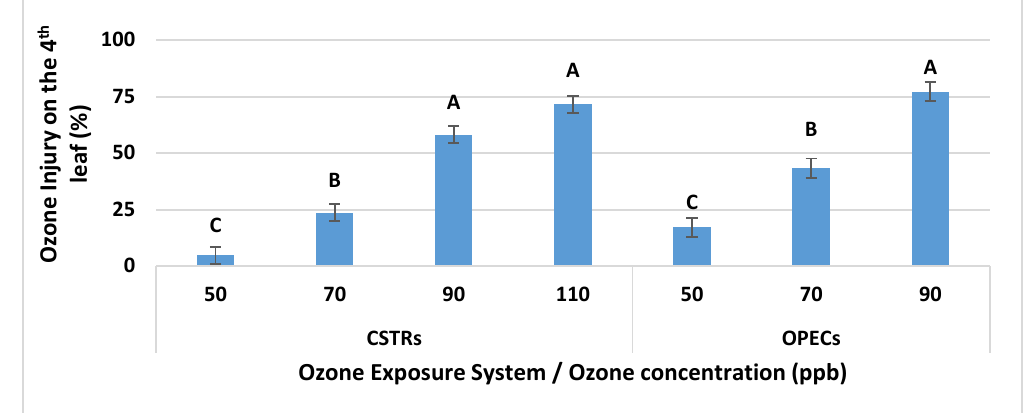
Figure 3. The overall average (±SE) of ozone injury of eight rust near-universal susceptible (RnUS) wheat genotypes, under different O 3 levels, for different exposure periods, in two different systems: continuous stirred tank reactors (CSTRs) and outdoor plant environment chambers (OPECs). Means within each exposure system were statistically separated using Tukey-Kramer adjustment for multiple comparisons. Means marked with the same letter are not significantly different at α = 0 .05.